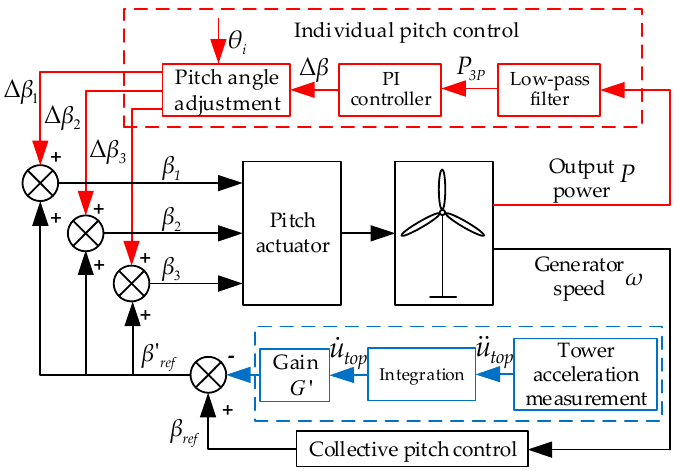
Figure 3. The proposed individual pitch control strategy.